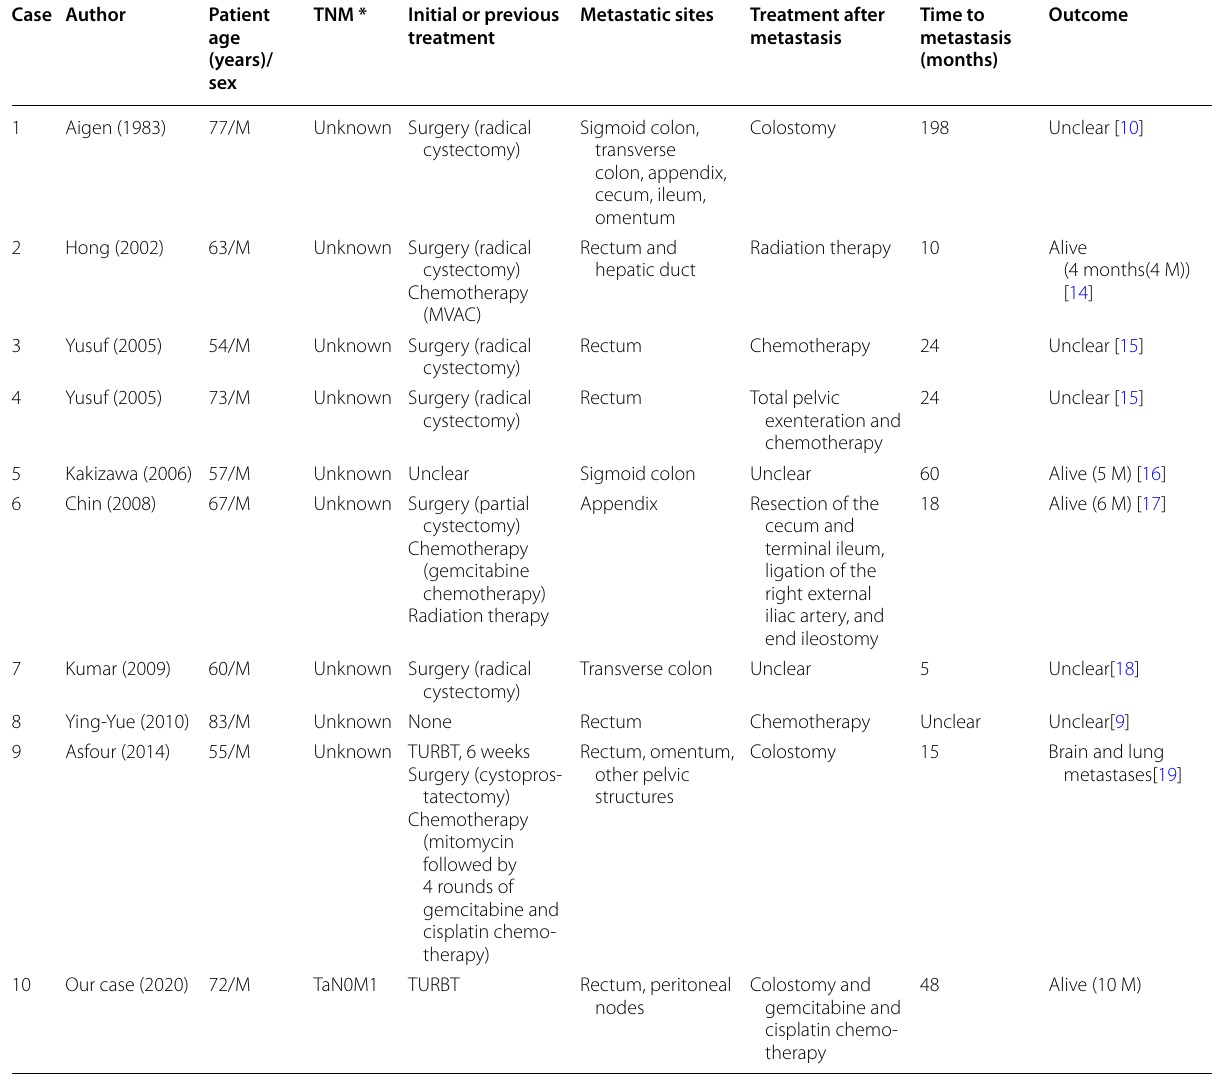
*TNM at initial diagnosis of urothelial